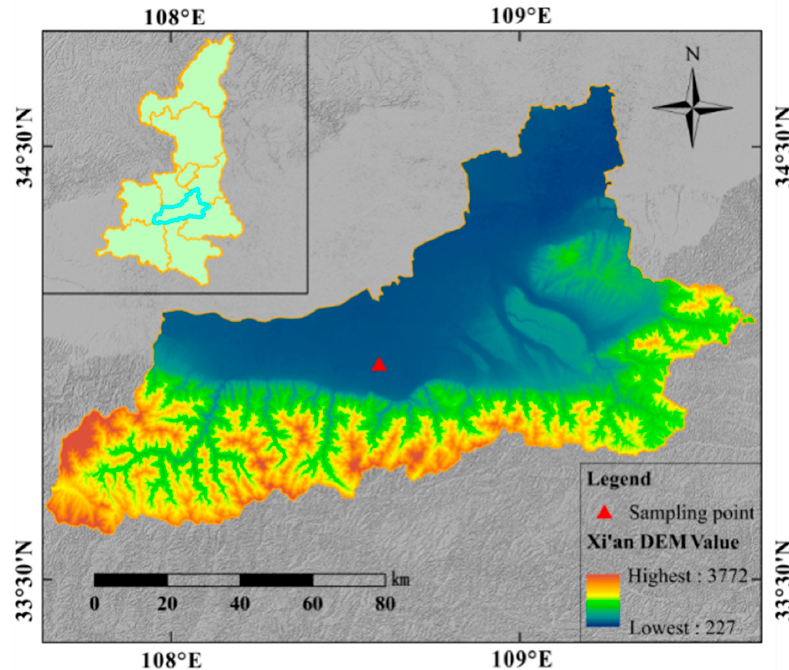
Figure 2. Location map of the sampling site.